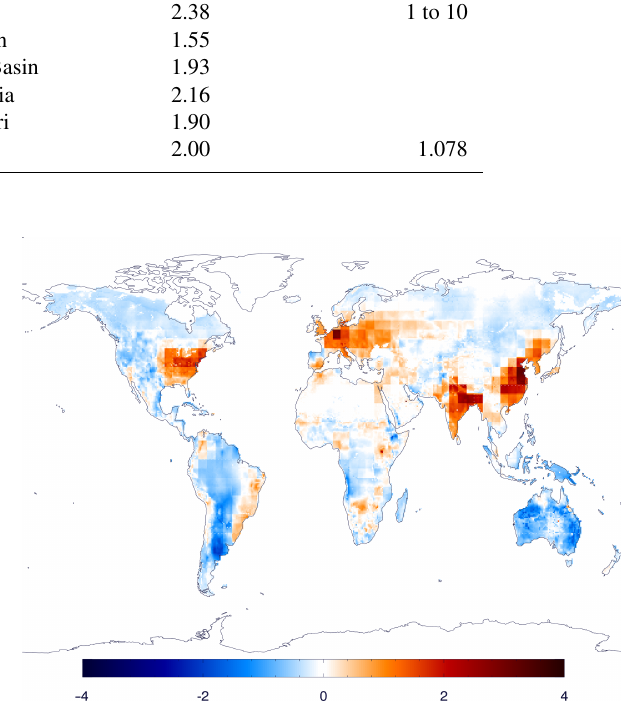
Figure 8. Excess of atmospheric N deposition over NNF during the 1990s (gNm − 2 yr − 1 ) . Positive values imply N overload; negative values imply N limitation. The block structure is due to the coarse resolution of the N deposition